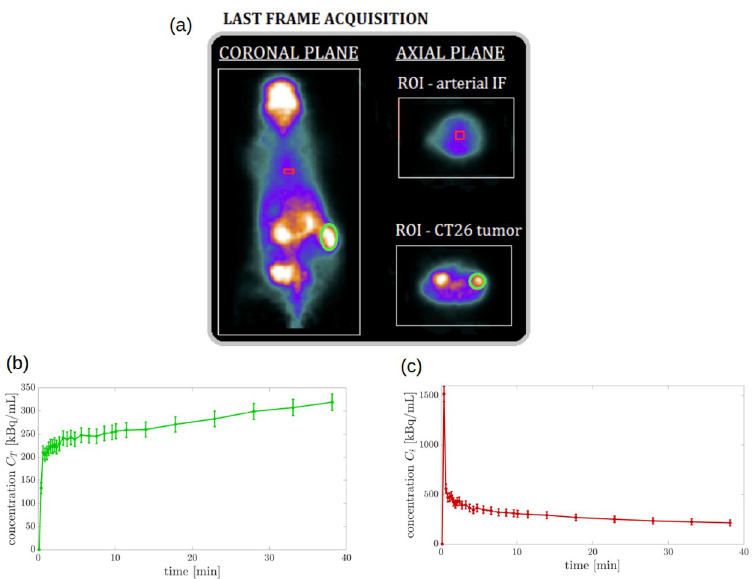
Fig 2. FDG-PET experimental data acquired for mouse m1. (a) Last frame of the FDG-PET acquisition of the murine model m1 with ROIs around the CT26 tumor (green color) and the aortic arc (red color). (b) The time- dependent ROI concentration curve of the CT26 tumor C and its standard deviation, related to experiment m1. (c) T The time-dependent concentration curve of the arterial input function C i and its standard deviation, related to experiment